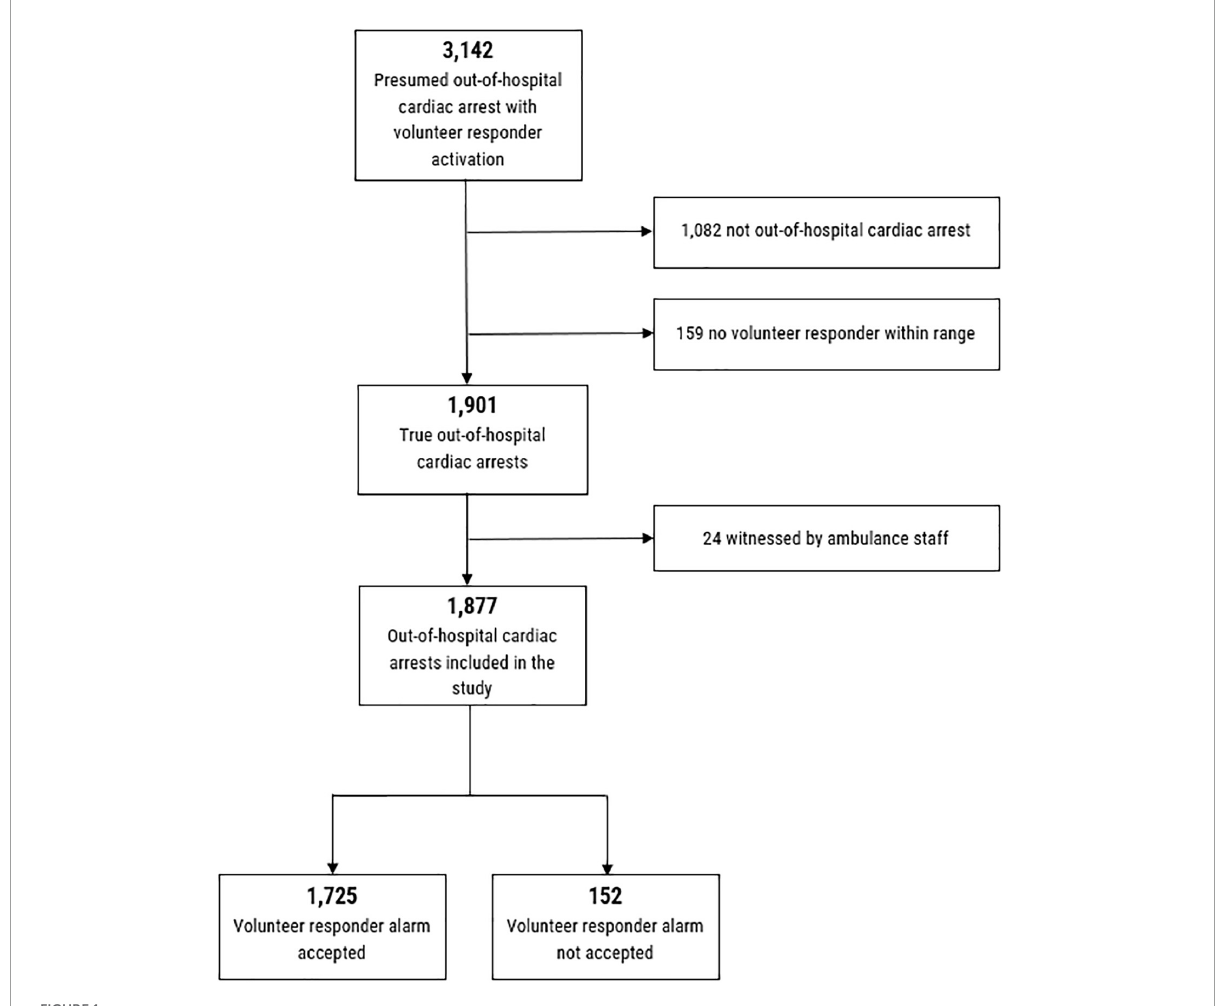
FIGURE1 Flowchart of included